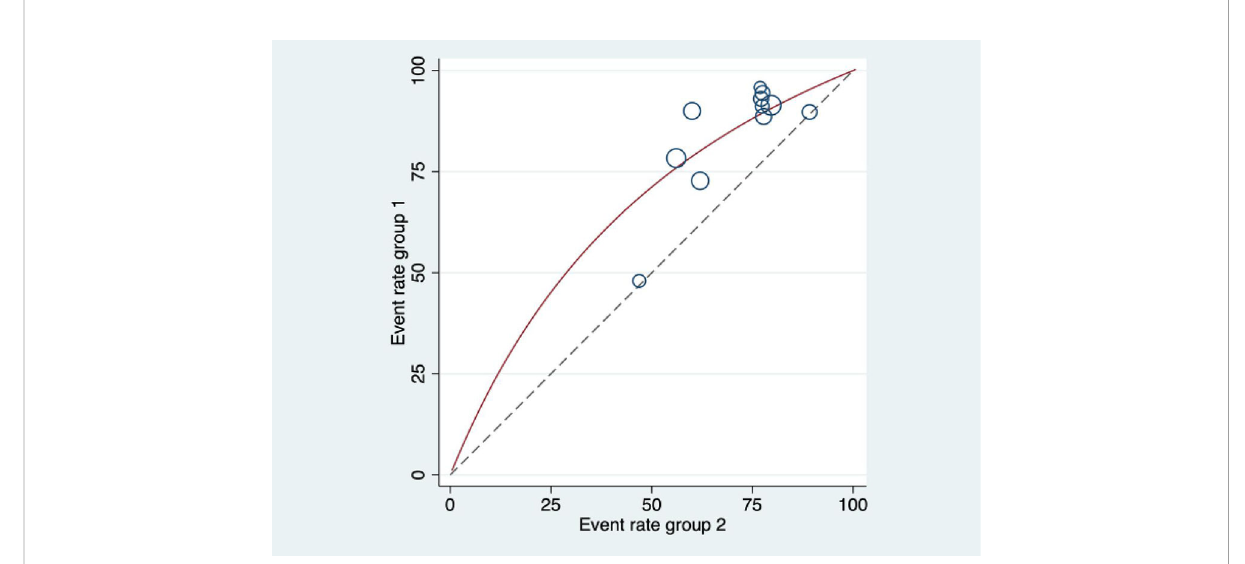
FIGURE 6 Labbe diagram for heterogeneity evaluation. The dotted line in the fi gure is the effective line, and the red curve is the combined value. The distance between the two lines represents the magnitude of heterogeneity.